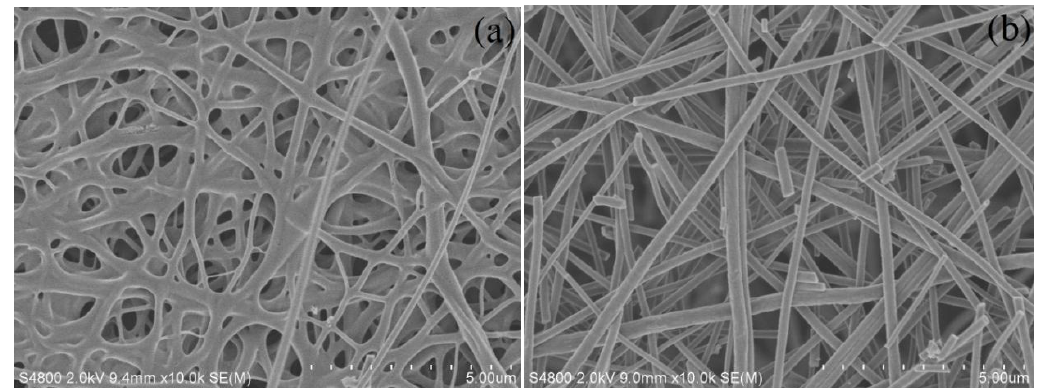
Figure 1. SEM images of ( a ) CNFs and ( b )